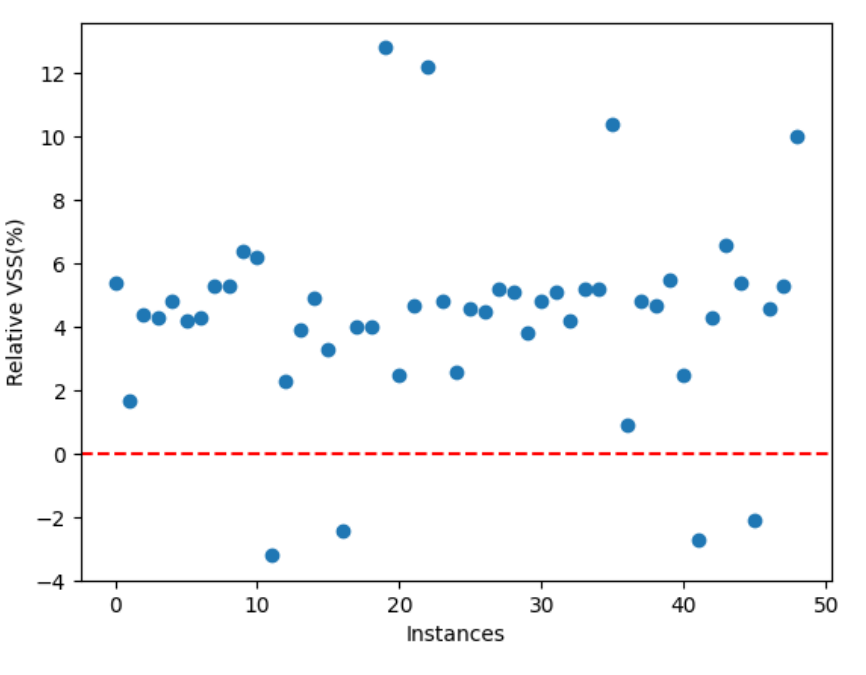
Figure 7. Relative value of